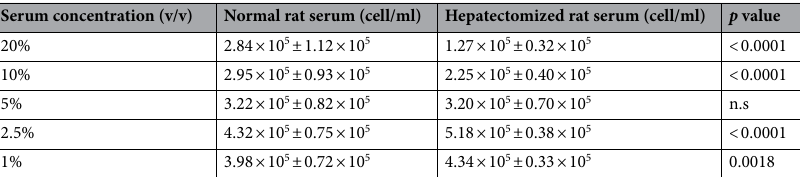
Serum concentration